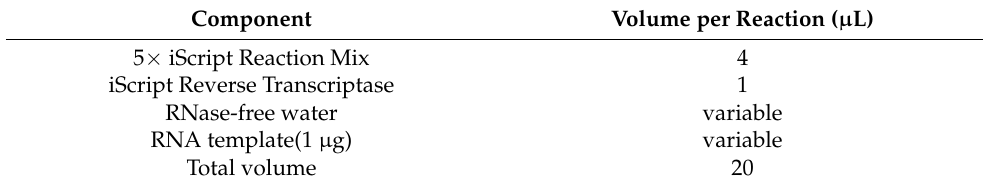
Table 3. Components of reverse-transcription